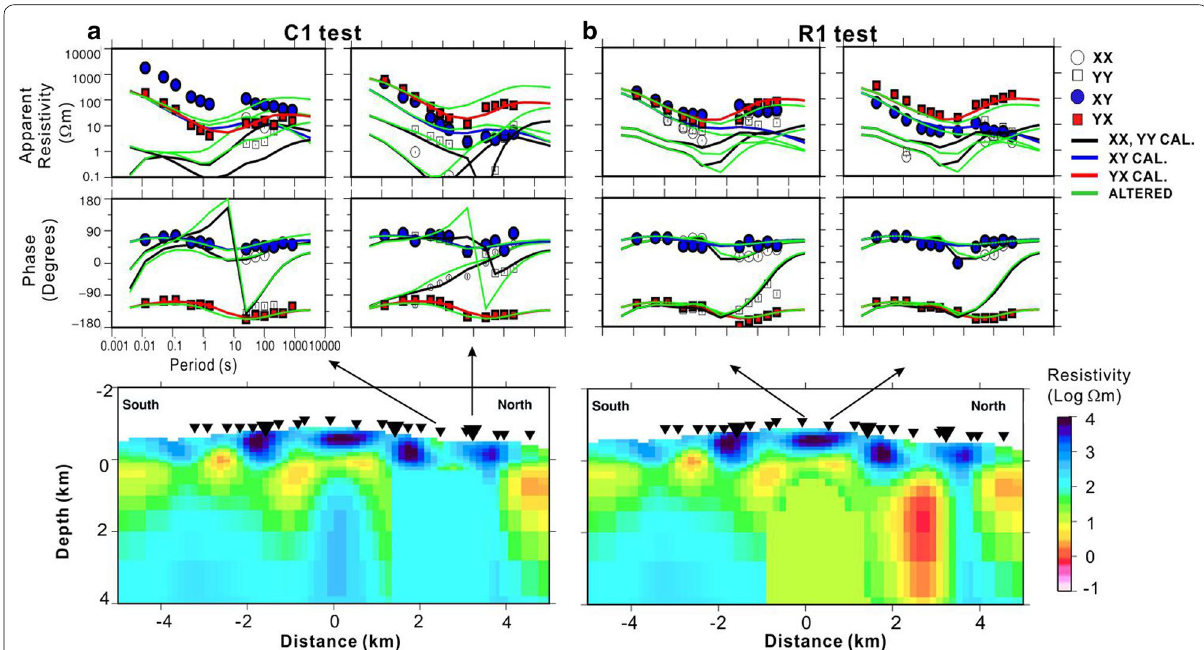
Fig. 7 Sensitivity tests of two different anomalies: C1 and R1. The final model RMS is 1.60. a Altering the C1 anomaly using 100 Ωm blocks over 2.1 km 2.4 km 4.7 km area (in N–S, E–W, and vertical directions) increasing RMS to be 3.20. b Altering the R1 anomaly using 10 Ωm blocks × × over approximately 2.2 km 2.4 km 4.5 km area (in N–S, E–W, and vertical directions) causing RMS to be 1.70. The upper panels show the × × corresponding sounding curves after sensitivity tests. In each sounding curve, the upper and lower sub-panels correspond to the apparent resistivity and phase, respectively. The symbols indicate observed data for each component. The green lines represent calculated data from the altered models. The bottom panels show the N–S profile after the blocks were